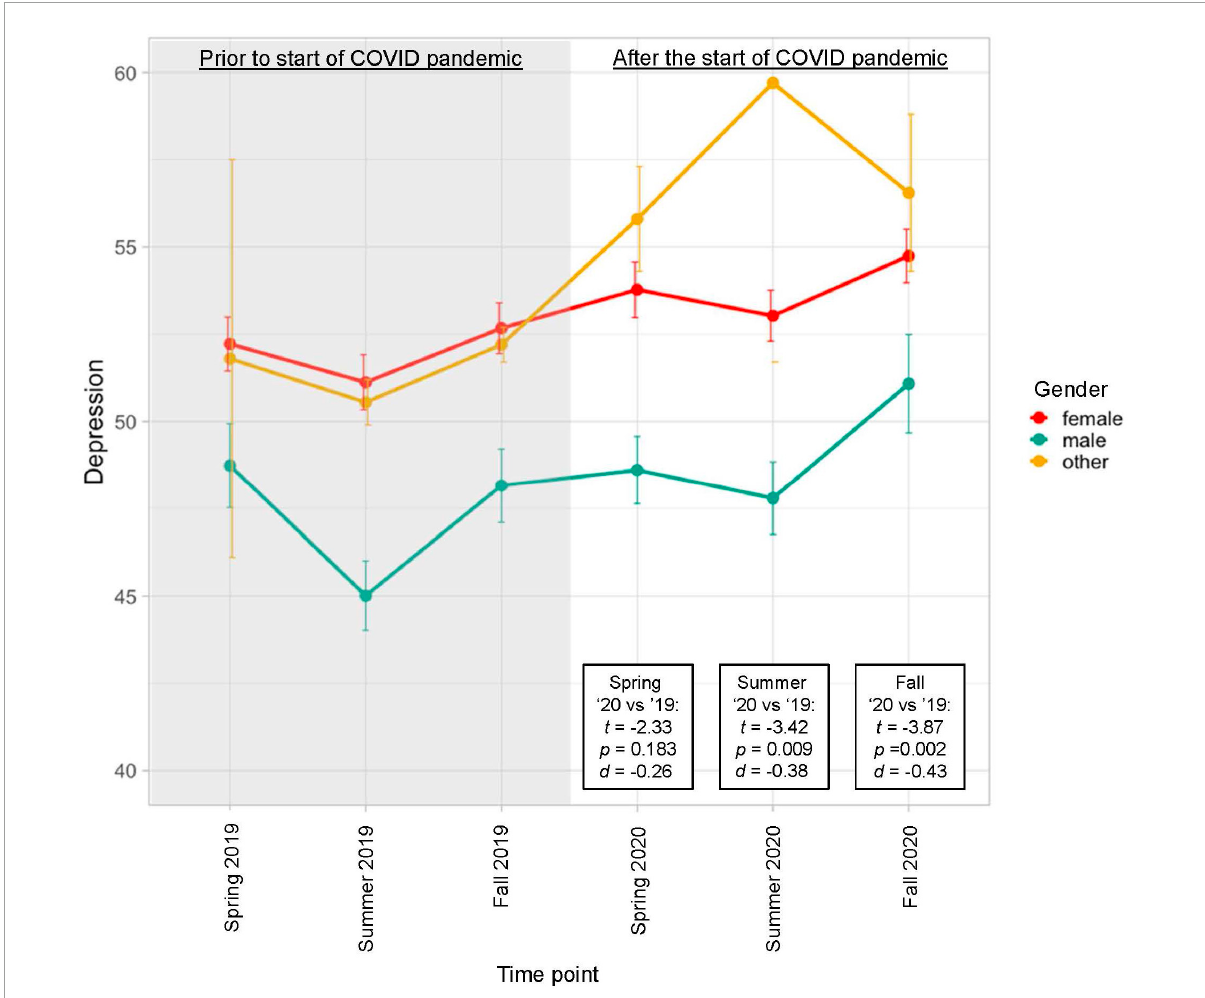
FIGURE1 Average depression symptom severity reported over time by group. Linear mixed effects models (with gender included as a covariate, determined via BIC) revealed a significant increase in symptoms over time [ F (5,807) = 10.36, p < 0.001]. T statistics listed in the figure were obtained from Tukey’s HSD tests comparing corresponding time points from 2020 to